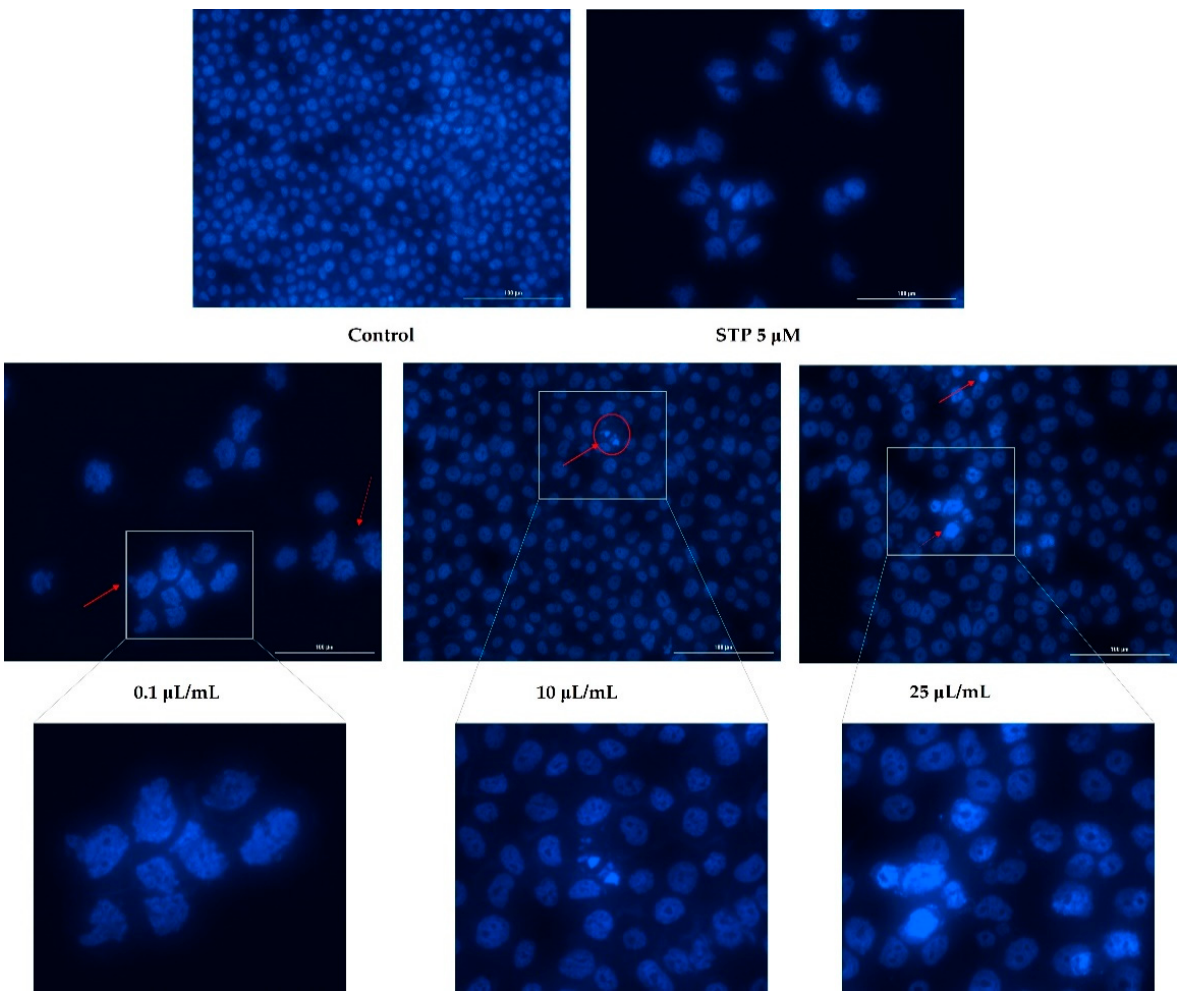
Figure 5. Keratinocytes—HaCaT nuclei stained with Hoechst 33342 dye after 24 h treatment with nicotine (0.1, 10, and 25 µ L/mL). Staurosporine (5 µ M) was used as the positive control for apoptotic changes at the nuclear level. The red arrows indicate signs of apoptosis. The scale bars represent 100 µ m.